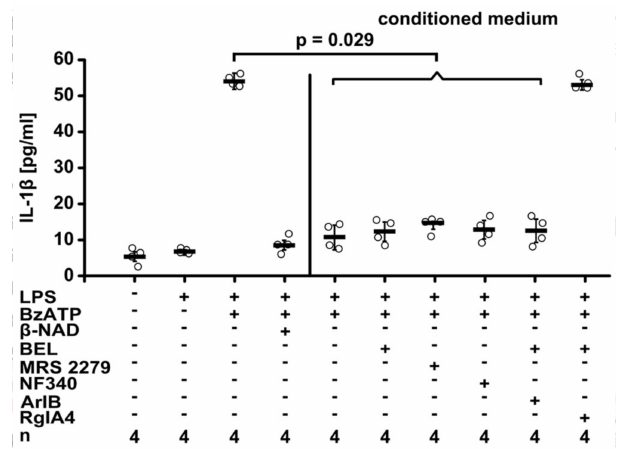
Figure 5. β -NAD triggers the release of a bioactive soluble factor. Human monocytic U937 cells were primed with LPS (1 µ g/mL, 5 h) and treated with β -NAD (1 mM) for 30 min to produce conditioned medium. Thereafter, the conditioned medium was harvested and applied to another set of LPS-primed U937 cells together with 2 (cid:48) (3 (cid:48) )- O -(4-benzoylbenzoyl)adenosine-5 (cid:48) -triphosphate (BzATP; 100 µ M) and incubated for 30 min. The P2Y1 antagonist MRS2279 (500 nM), the P2Y11 antagonist NF340 (5 µ M), the iPLA2 inhibitor bromoenol lactone (BEL; 50 µ M), the α 7 nAChR antagonist α -conotoxin ArIB [V11L, V16D] (500 nM), or the α 9 α 10 nAChR antagonist α -conotoxin RgIA4 (200 nM) were applied together with the conditioned medium. β -NAD (1 mM) was included in this experiment as a positive control in the absence of conditioned medium. The release of IL-1 β to the cell culture supernatant was measured by ELISA. Data are presented as individual data points, bars indicate median, whiskers encompass the 25th to 75th percentile, Kruskal-Wallis test followed by the Mann-Whitney rank sum